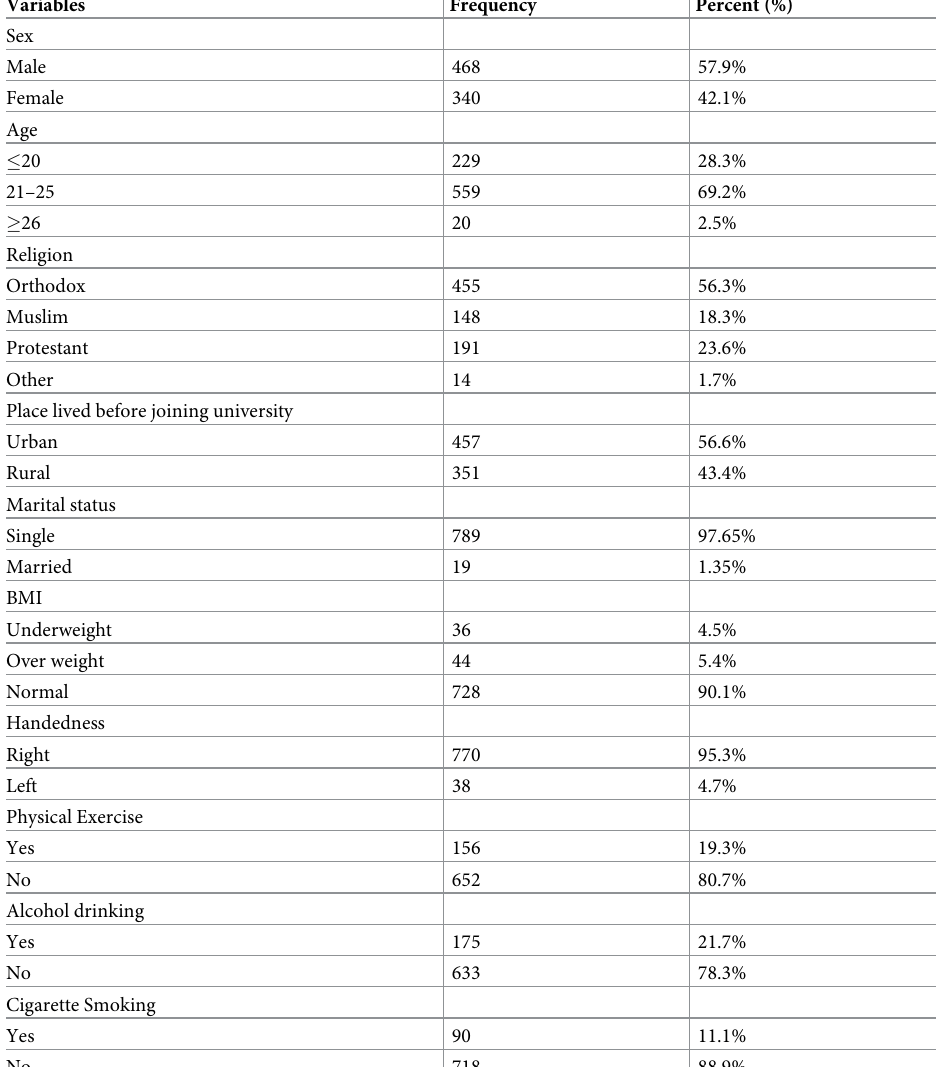
Table 1. Socio demographic and behavioral characteristics of smart phone users at University of Gondar, 2020 (N =